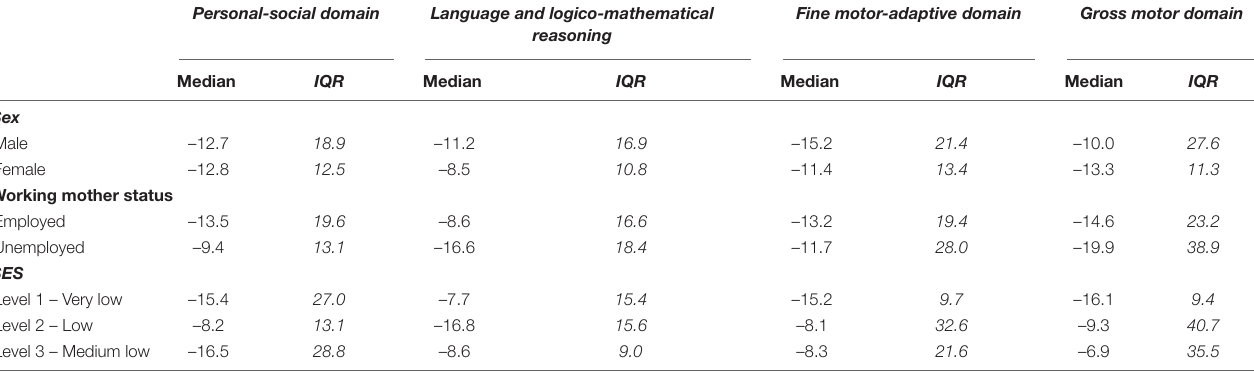
TABLE 3 | Median and data spread (Interquartile range-IQR) for the Net percentage change index (NET) between scores for Haizea-Llevant (HLL) and CARE report by developmental dimensions. Personal-social domain